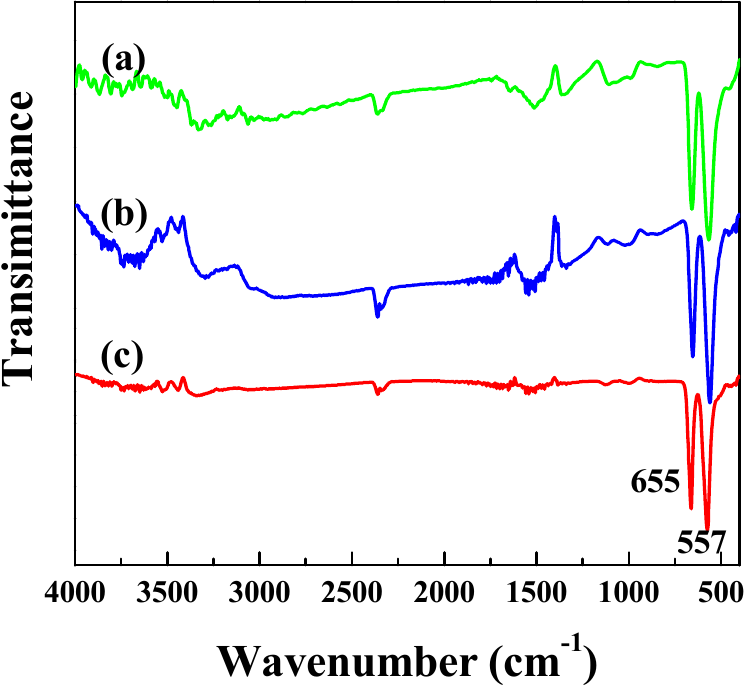
Figure 4. FT-IR spectra of Ni 0.5 Cu 0.5 Co 2 O 4 nanoparticles ( a ), urchin-like microspheres ( b ), and nanoplatelets ( c ).